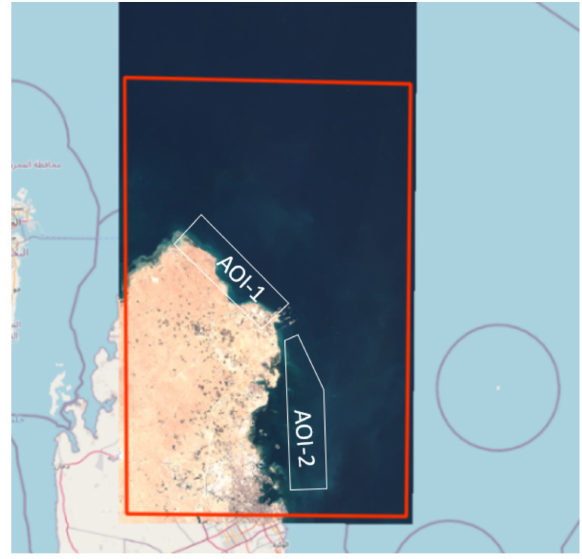
Figure 30. Qatar’s two test areas of